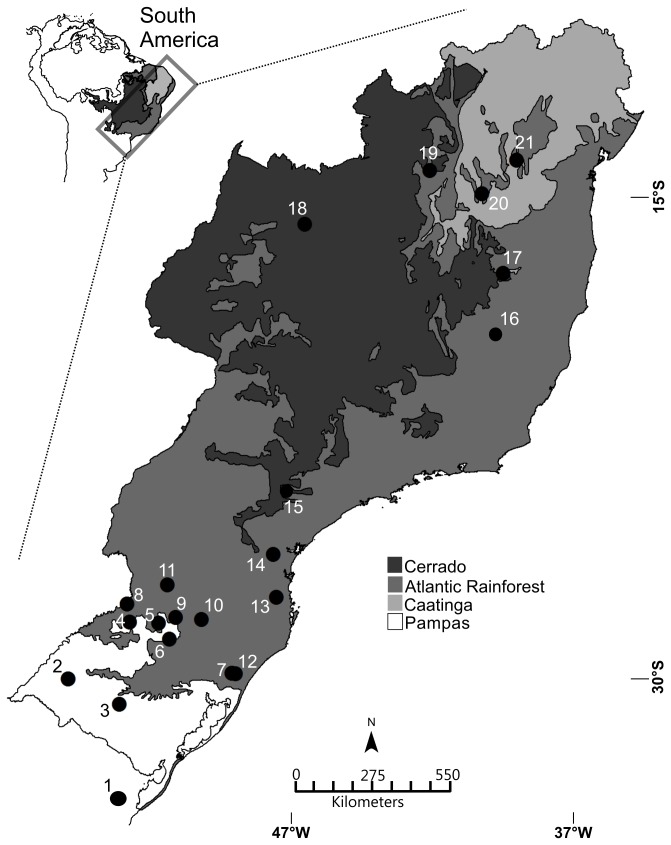
Biomes and localities sampled in South America.Different shades of gray correspond to different biomes, as indicated in the legend. 1. Reserva de Santa Teresa, Rocha, UY (-34.36; -53.46); 2. Alegrete, RS, BR (-55.71; -29.57); 3. Margarida do Sul, RS, BR (-54.07; -30.37); 4. Rondinha, RS, BR (-53.75; -27.75); 5. Ronda Alta, RS, BR (-52.82; -27.79); 6. Passo Fundo, RS, BR (-52.48; -28.29); 7. Terra de Areia, RS, BR(-50.48; -29.39); 8. Derrubadas, RS, BR (-53.83; -27.17); 9. Erechim, RS, BR (-52.28; -27.60); 10. Barracão, RS, BR (-51.46; -27.67); 11. São Domingos, SC, BR (-52.54; -26.56) 12. São Francisco de Paula, RS, BR (-50.37; -29.40); 13. Blumenau, SC, BR (-49.07; -26.96) 14. São José dos Pinhais, PR, BR (-49.17; -25.58); 15. Capão Bonito, SP, BR (-24.06; -48.32); 16. Capitão Andrade, MG, BR (-19.06; -41.81) 17. Itinga, MG, BR (-41.82; -16.61) 18. Mimoso de Goiás, GO, BR (-15.06; -48.19); 19. Correntina, BA, BR (-44.16; -13.34); 20. Caetité, BA, BR (-42.50;-14.07); 21. Mucugê, BA, BR (-41.39; -13). BR: Brazil. UY: Uruguay. Brazilian States: RS-Rio Grande do Sul, SC-Santa Catarina, PR-Paraná, SP- São Paulo, MG-Minas Gerais, GO-Goiás, BA-Bahia. Coordinates in parentheses are given in decimal degrees.